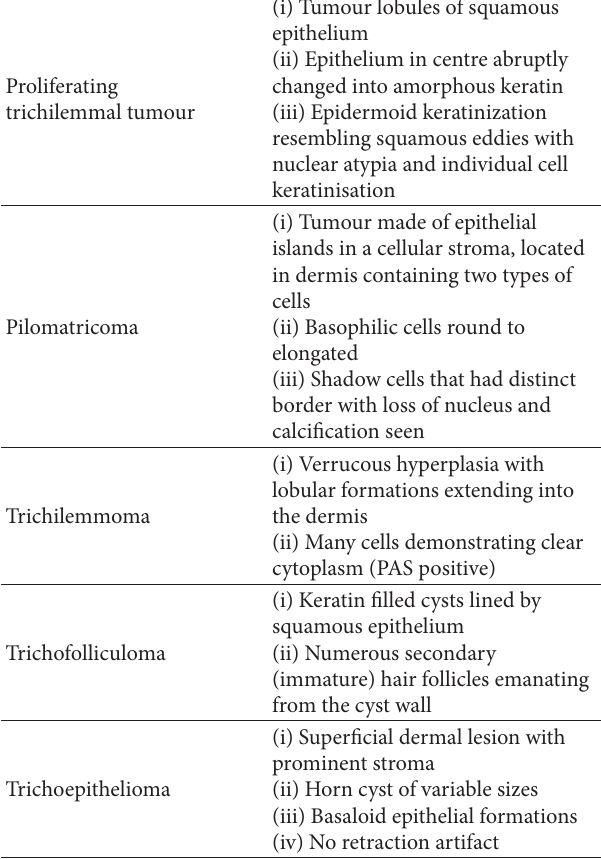
Table 7: Salient histopathological features of follicular